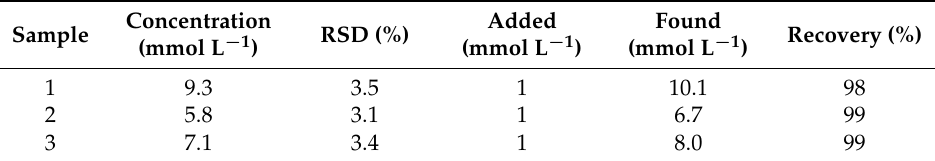
Table 2. Amperometric detection of glucose in